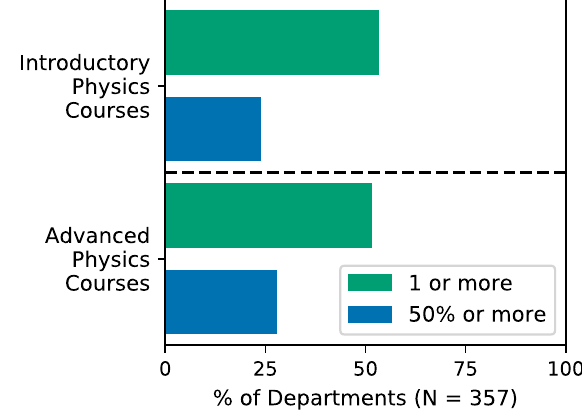
FIG. 3. Out of the 357 unique departments, 191 (54%)